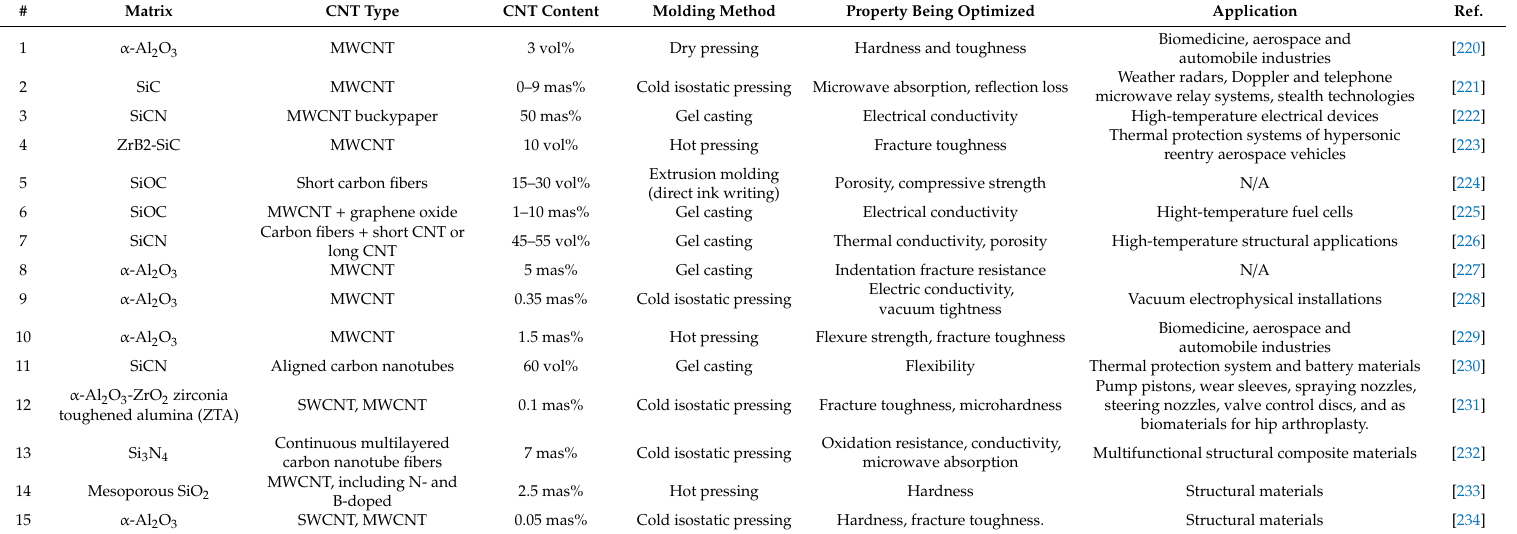
Table 1. Examples of ceramic matrix composites reinforced with carbon